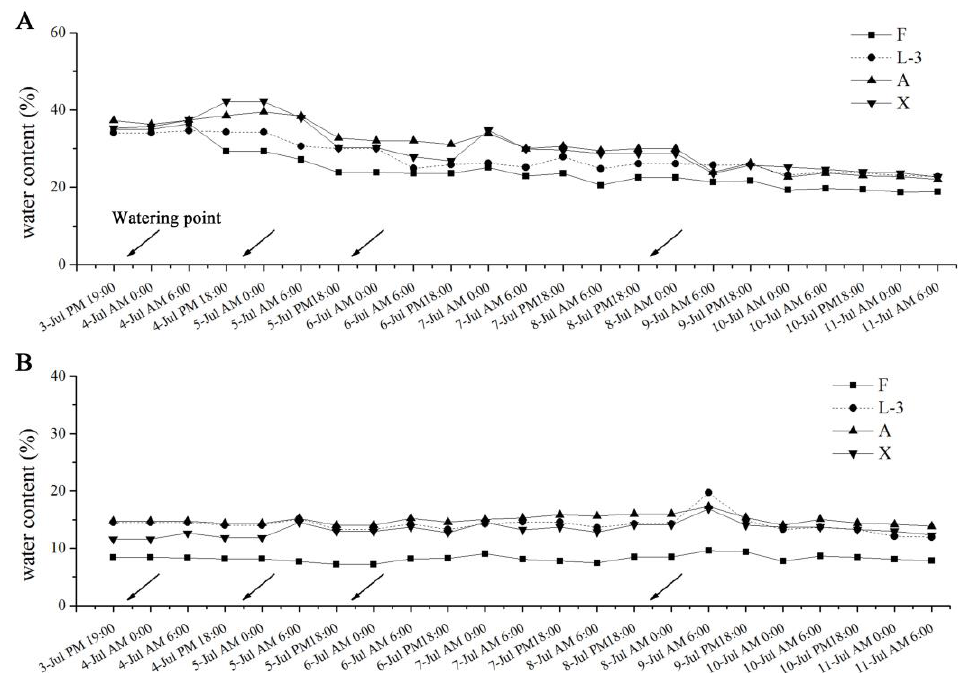
Figure 4. Soil water content under DD (drought) conditions. ( A ), top pots. ( B ), bottom pots. The arrows indicate the time points of watering. F, L-3, A, and X indicate different potato cultivars. F, Favorita cultivar. L-3, Longshu No.3 cultivar. A, Atlantic cultivar. X, Xindaping cultivar.